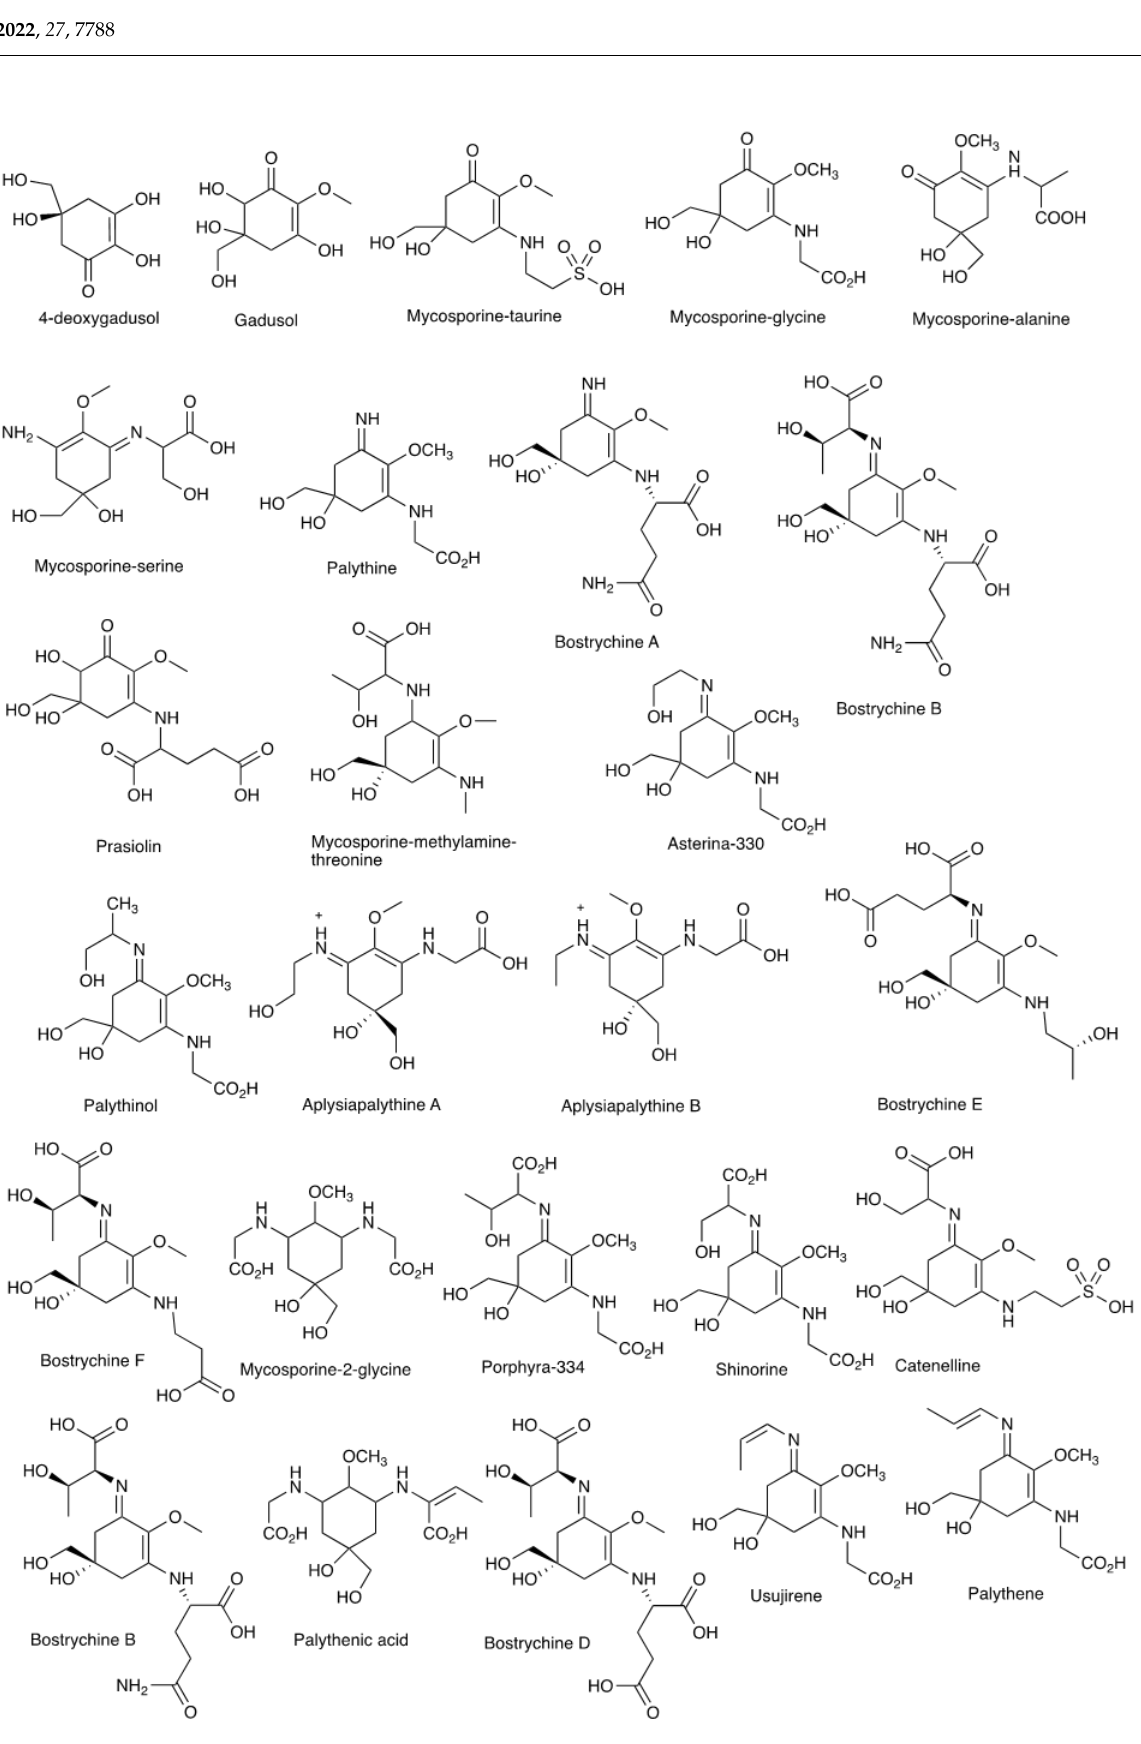
Figure 4. Structure of MAAs from red seaweed. The chemical diversity and the accumulation of MAAs in seaweeds depend on different parameters such as water depth, harvest time, nutrient availability, pH,